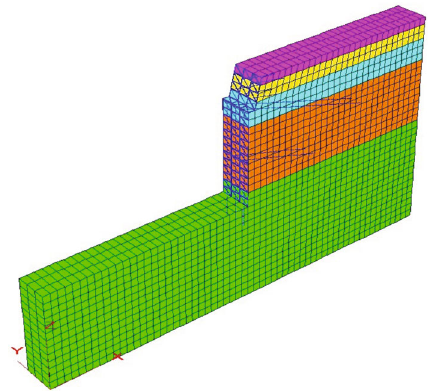
Figure 3: Deep foundation pit excavation model.